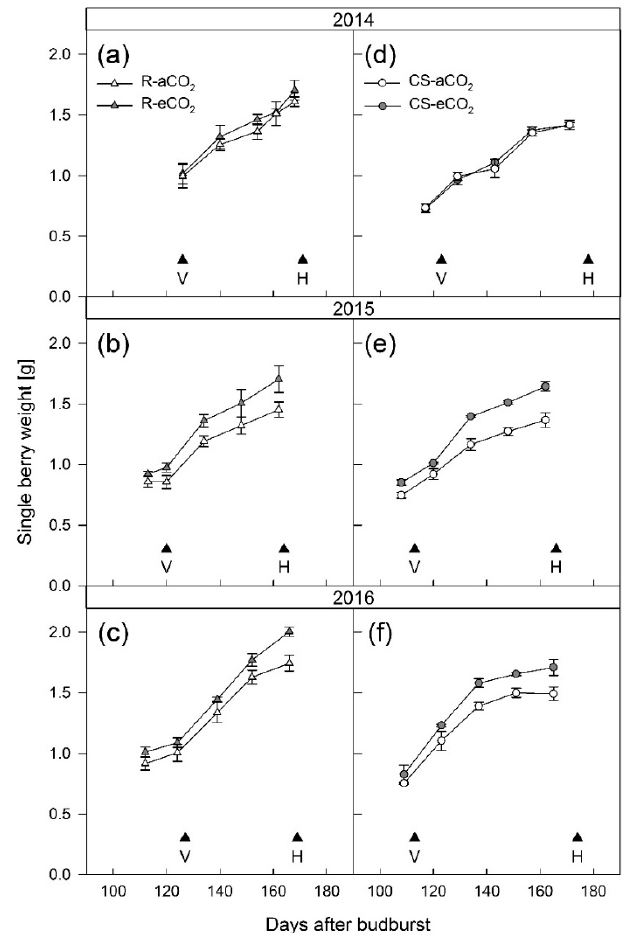
Figure 1. Single berry weights of Riesling ( a – c ) and Cabernet Sauvignon ( d – f ) for the two treatments aCO 2 and eCO 2 and the three seasons 2014, 2015, and 2016 during berry development. Letters indicate development stages veraison (V) and harvest (H). Mean values per treatment ± SD of the three FACE rings.